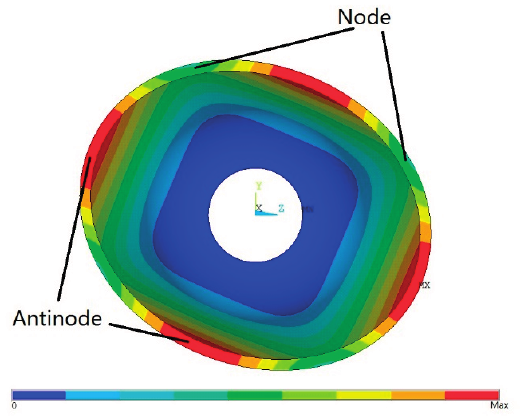
Figure 2. A bottom-up view of a resonator’s working mode (different colors represent different